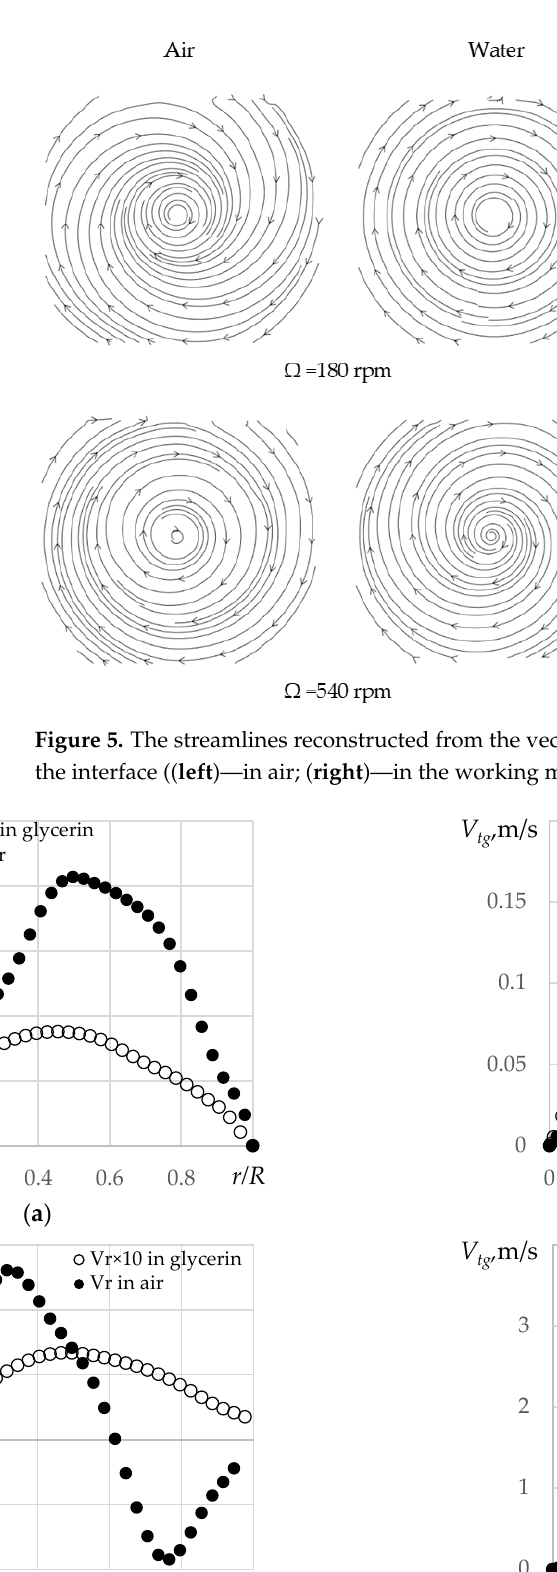
( b ) Figure 4. Visualization of the motion of the model fluid: ( a ) the flow diverging from the axis below the interface and ( b ) the flow converging to the axis near the bottom at Ω = 900 rpm, h g = 0.5 h .